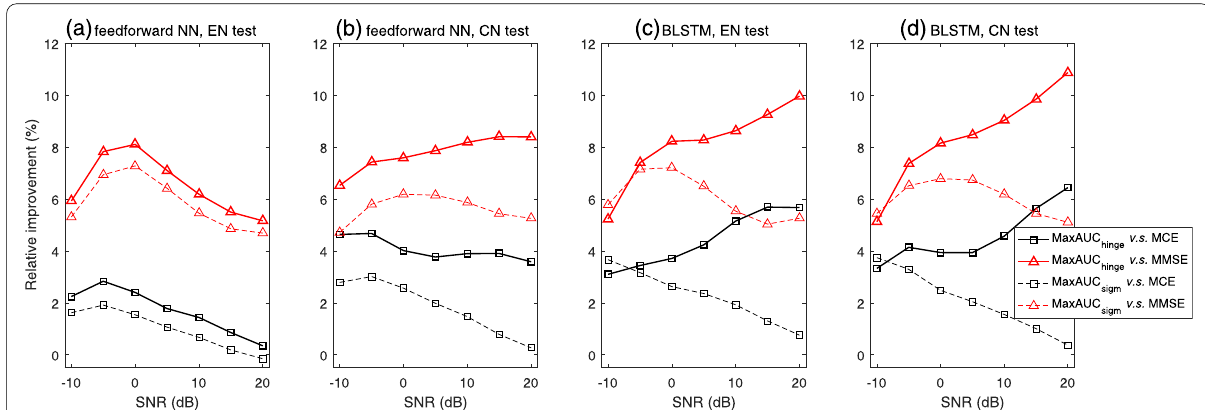
Fig. 3 Relative AUC improvement of the proposed methods over the competitive methods, when MRCG is used as the acoustic feature. The terms “EN” and “CH” are short for English and Chinese respectively. The term “NN” is short for neural networks. a Feedforward neural network is used as the basic deep model; the evaluation is conducted on the English Noisy‑CHiME‑4 dataset. b Feedforward neural network is used; the evaluation is conducted on the Chinese Noisy‑THCHS‑30 dataset. c BLSTM is used; the evaluation is conducted on the English Noisy‑CHiME‑4 dataset. d BLSTM is used; the evaluation is conducted on the Chinese Noisy‑THCHS‑30 dataset